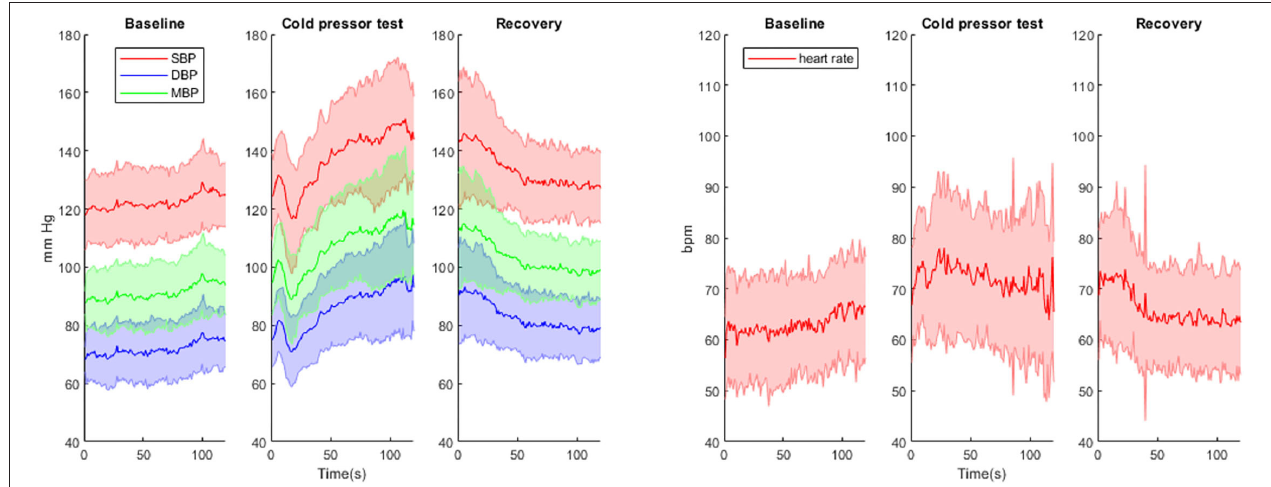
FIGURE 2 | Continuous blood pressure (mean + /-SD) and heart rate (mean + /-SD) measurements during baseline, cold pressor test and recovery. SBP, systolic blood pressure; DBP, diastolic blood pressure; MBP, mean blood pressure.